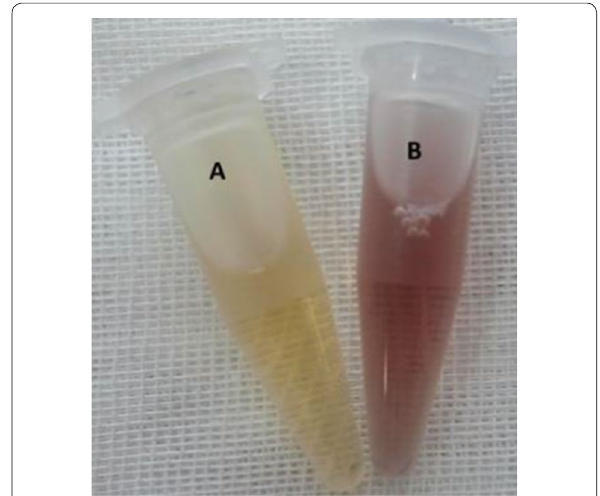
Fig. 1 Changes in the color of the fungal extract after biosynthesis of GNPs. A: The fungal extract before and B: after the GNPs